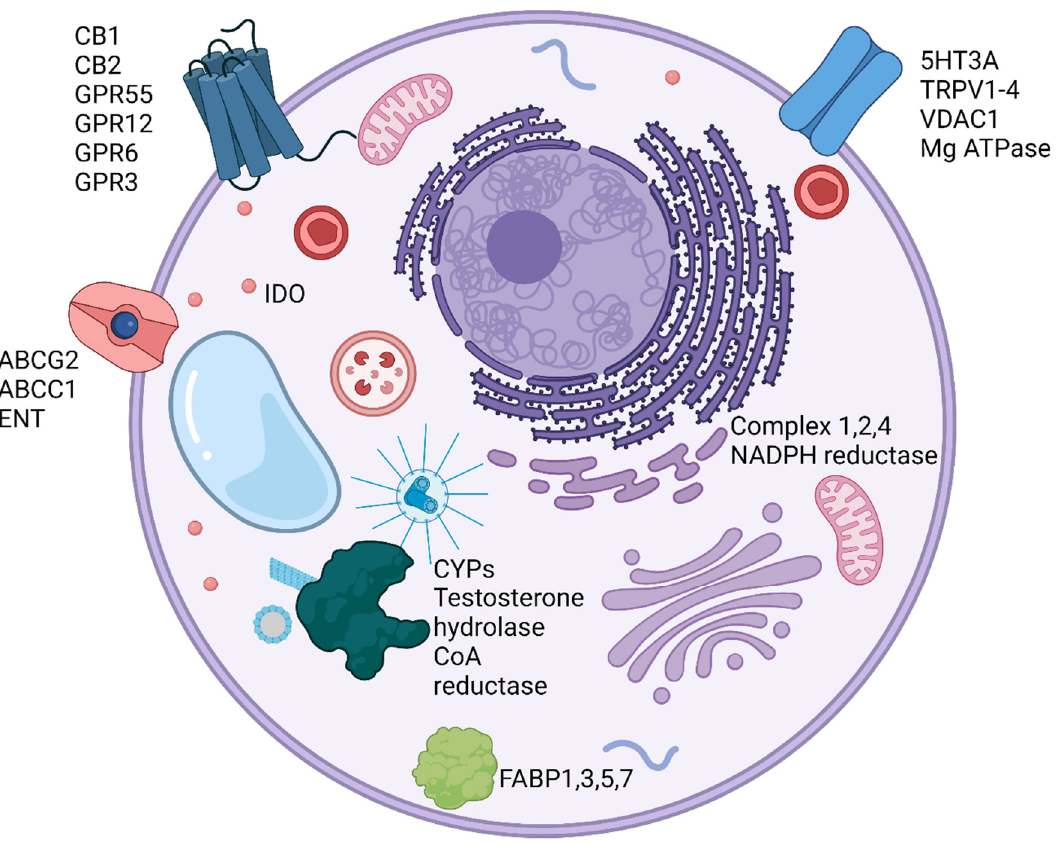
Figure 2. Molecular targets of CBD. Cellular proteins known to directly interact with CBD are shown. (Created with